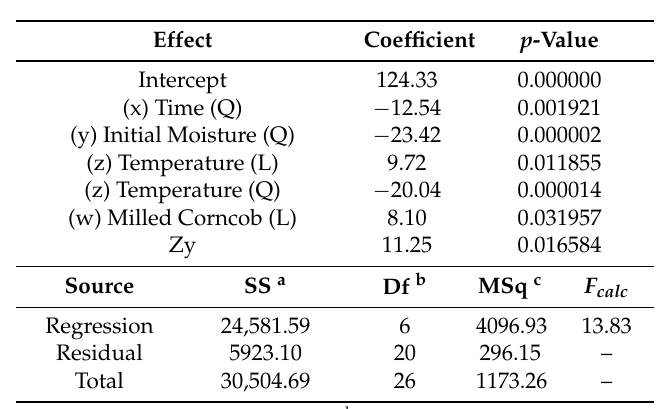
Table 3. Analysis of variance (ANOVA) for the second-order polynomial models and coefficient values for the production of laccases by P. sanguineus